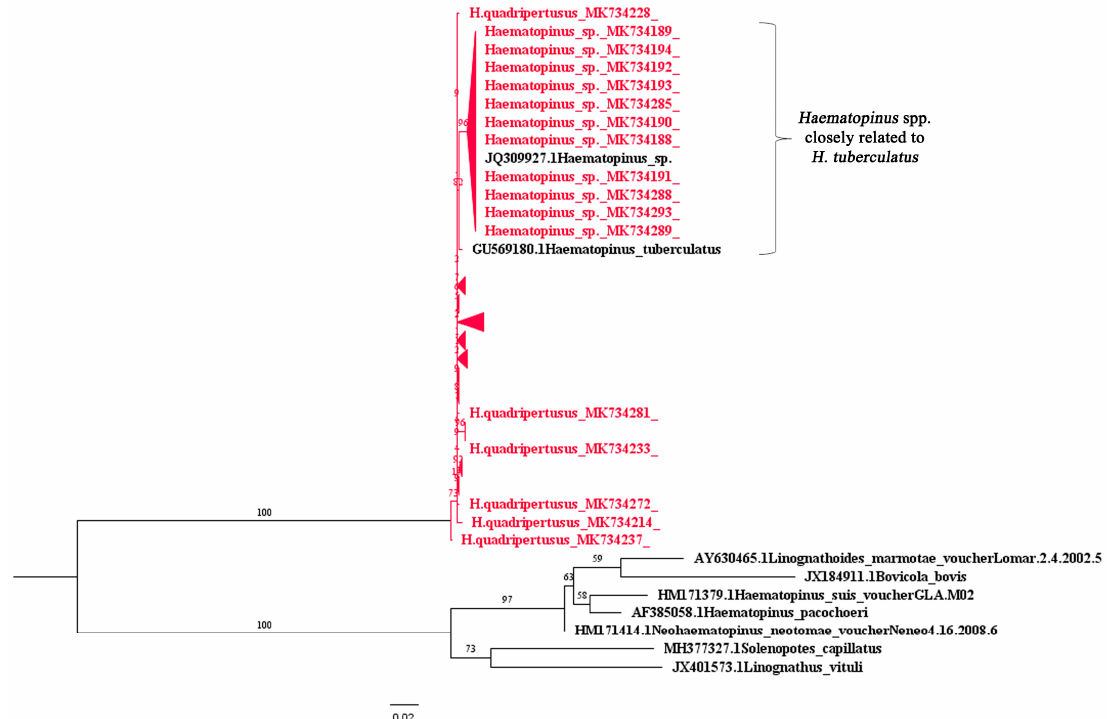
Figure 1. Phylogenetic tree of cattle lice constructed from partial 18S rRNA sequences. The maximum likelihood was constructed with IQ-TREE by using the maximum-likelihood method with 1000 ultrafast bootstrap replicates. The best-fit model of substitution was found using the auto function on the IQ-TREE web server. The sequences from this study are indicated with a red color.